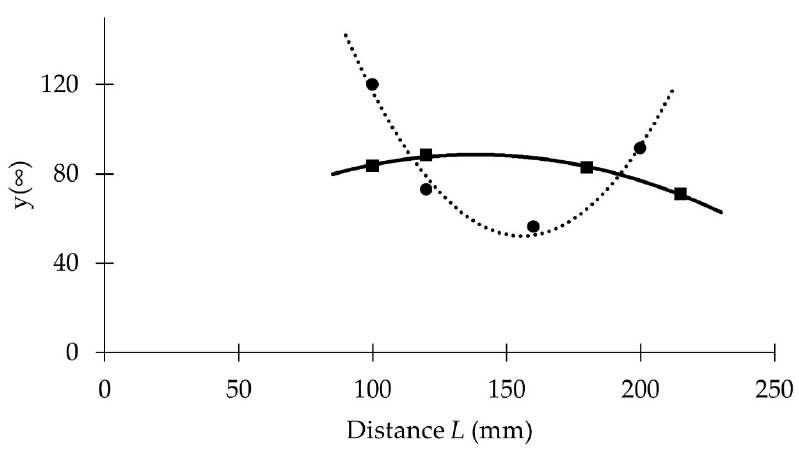
Figure 5. Polynomial regression of steady-state transfer function values on measured distance vector ( (cid:108) and dotted line–Planar case; (cid:110) and solid line–Corner case).